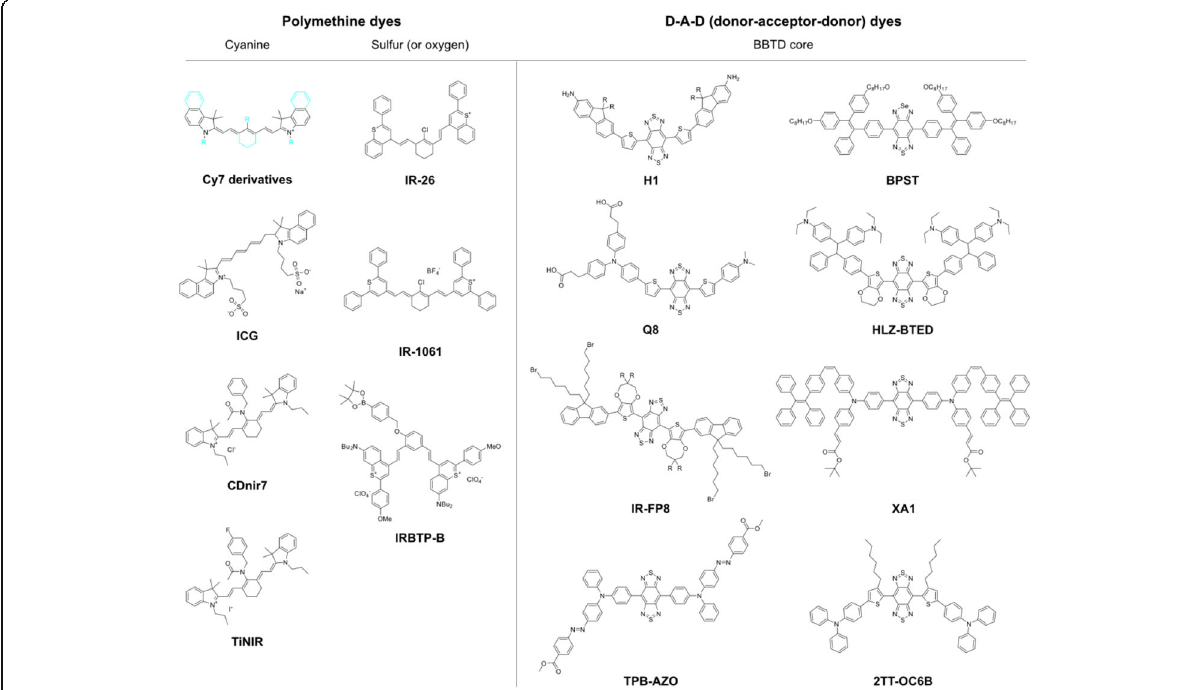
Fig. 7 Examples of the chemical structures of NIR organic dyes. Sky colors represent adjustable structures of Cy7 derivatives, such as ICG, CDnir7, TiNIR, etc.; BBTD, benzobisthadiazoles